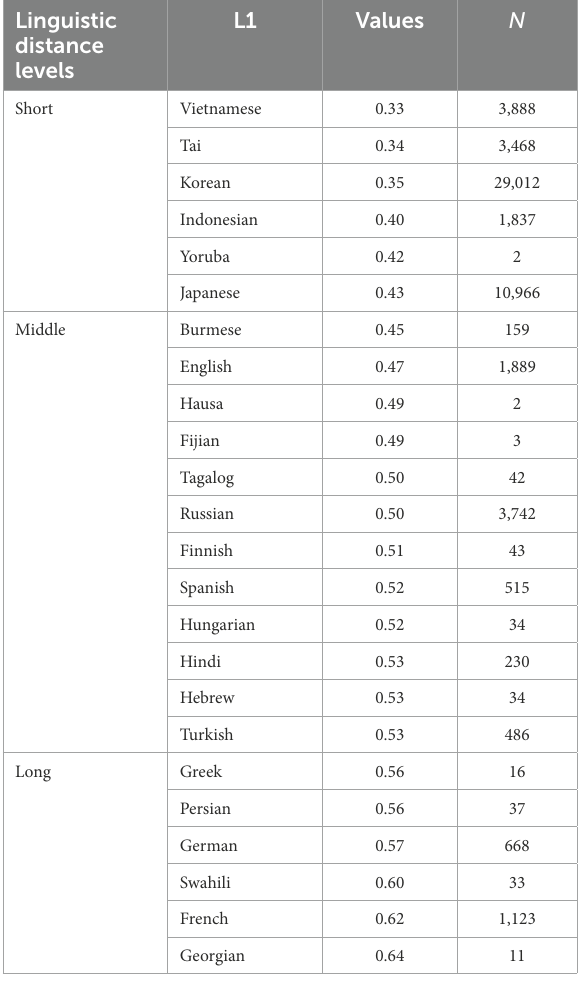
TABLE 1 Participant descriptive statistics with the linguistic distance between L1s and Chinese. Linguistic distance levels